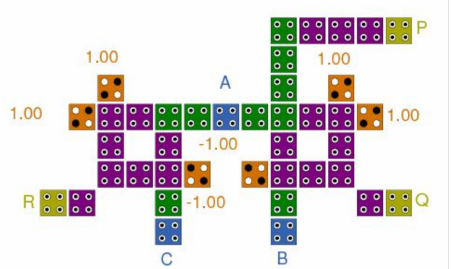
Figure 5. The layout of the double Feynman gate (proposed by Sasamal, Singh